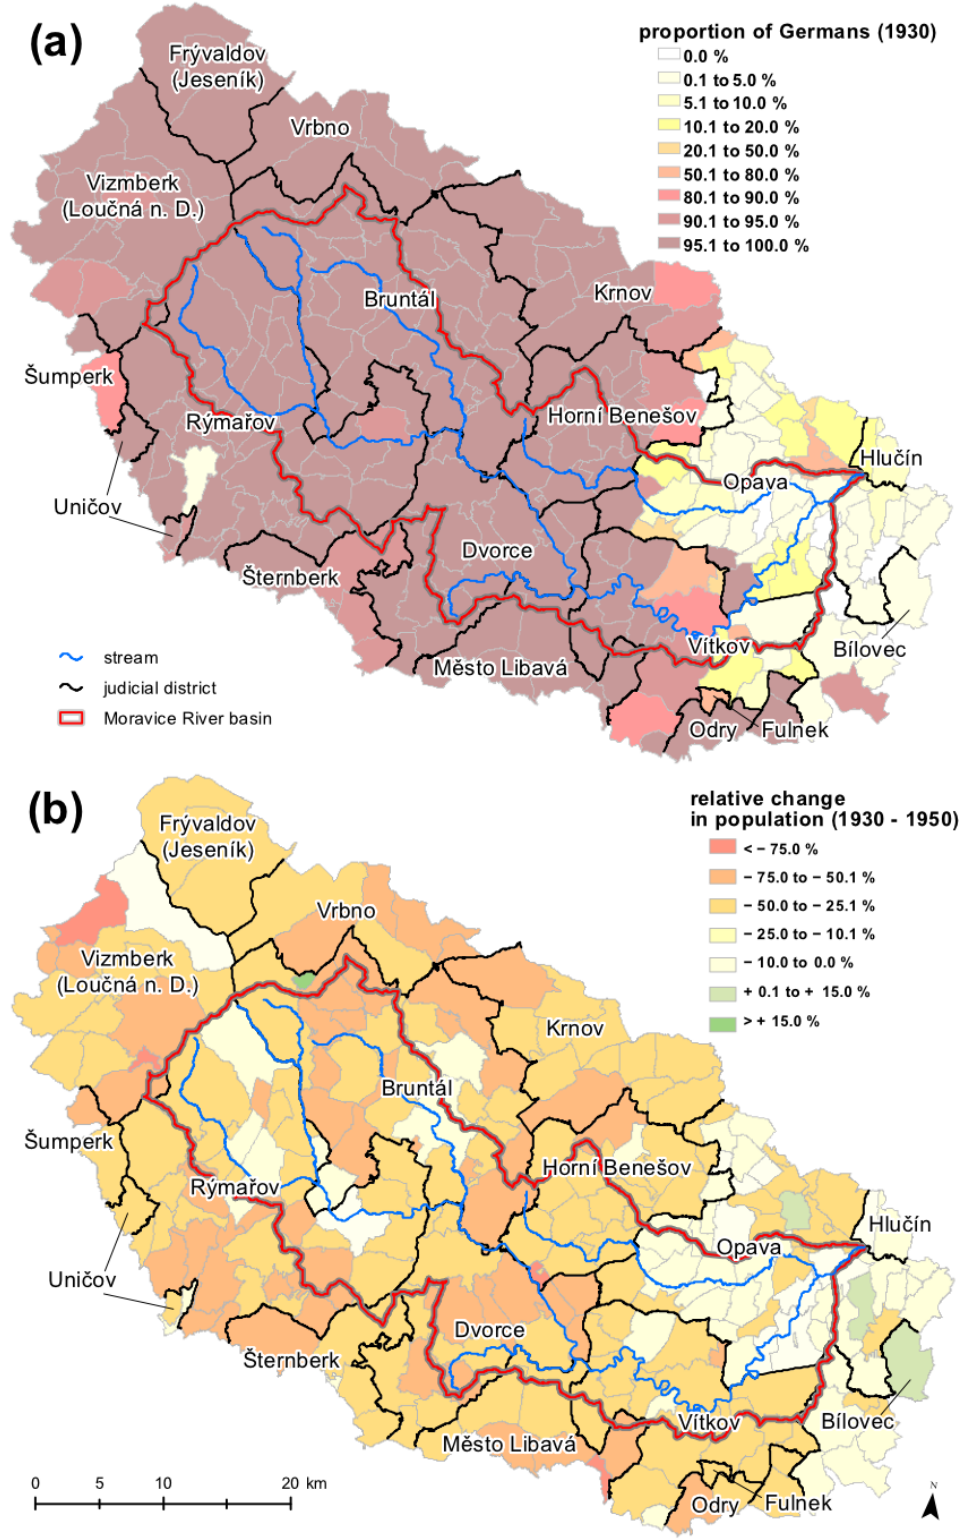
Figure 2. The characteristics of the population in the Moravice river basin: ( a ) the proportion of Germans in the municipalities in 1930; ( b ) the relative change in the population between 1930 and 1950 (source: Statistický lexikon obcí v republice Č eskoslovenské, II. Zem ě Moravskoslezská, 1930; Historický lexikon obcí Č eské republiky 1869–2005, I. díl, 2006).